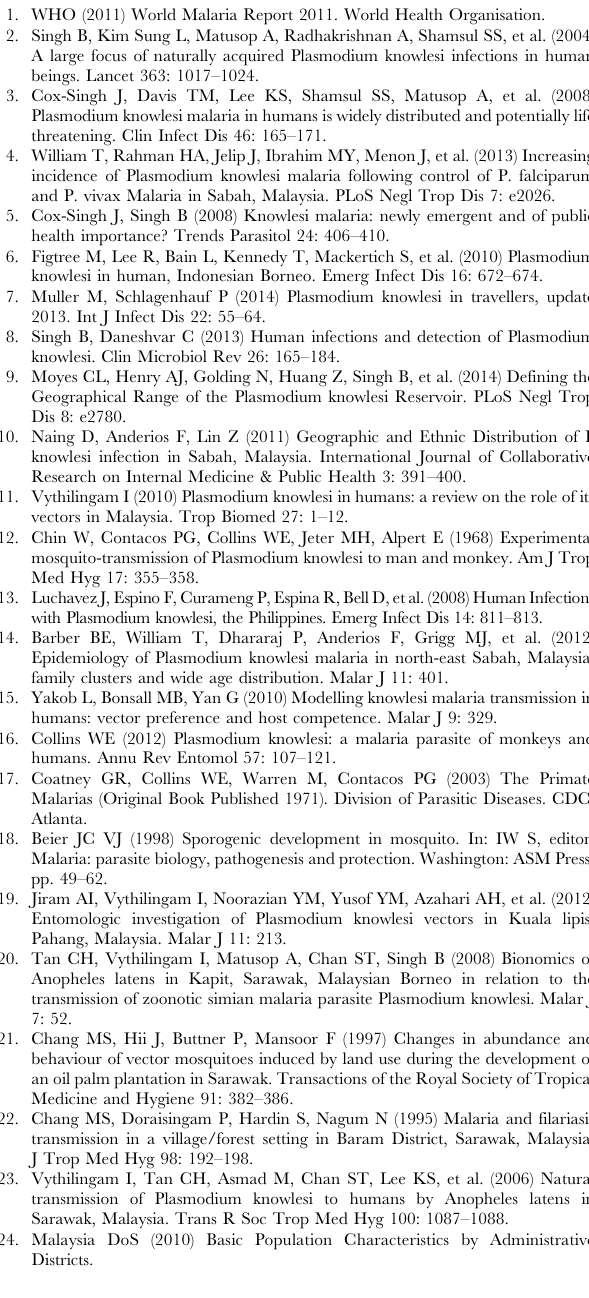
Figure S2 A) Human infection prevalence with changing values of transmission efficacies, and B) Human R0 (R 0H ) with changing values of transmission efficacies. Parasite transmission efficacies are the product of their respective transmission coefficients. (Macaque-macaque parasite transmission efficacy= C MV 6 C VM , and human-human parasite transmission efficacy= C HV 6 C VH ). The black contour line represents the 5% human infection prevalence and R0 H = 1 for figures A and B respectively. (TIF) Figure S3 Change in relative biting rates (the proportion of bites taken on macaques ( a MJ ) compared to humans ( a HJ )) in the jungle with ITN coverage. (TIF)